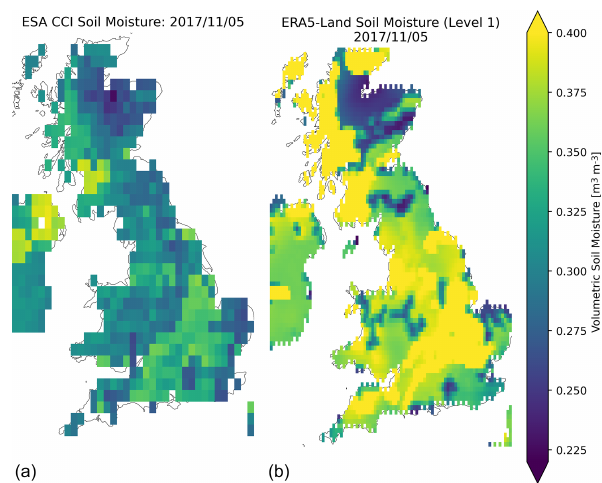
Figure B4. The spatial resolution of the two soil moisture prod- ucts – ESA CCI Combined (a) and ERA5-Land Soil Water Volume Level 1 (b) . The ERA5-Land data (87 × 93) contain roughly 6 times as many pixels as ESA CCI Soil Moisture (35 × 37).